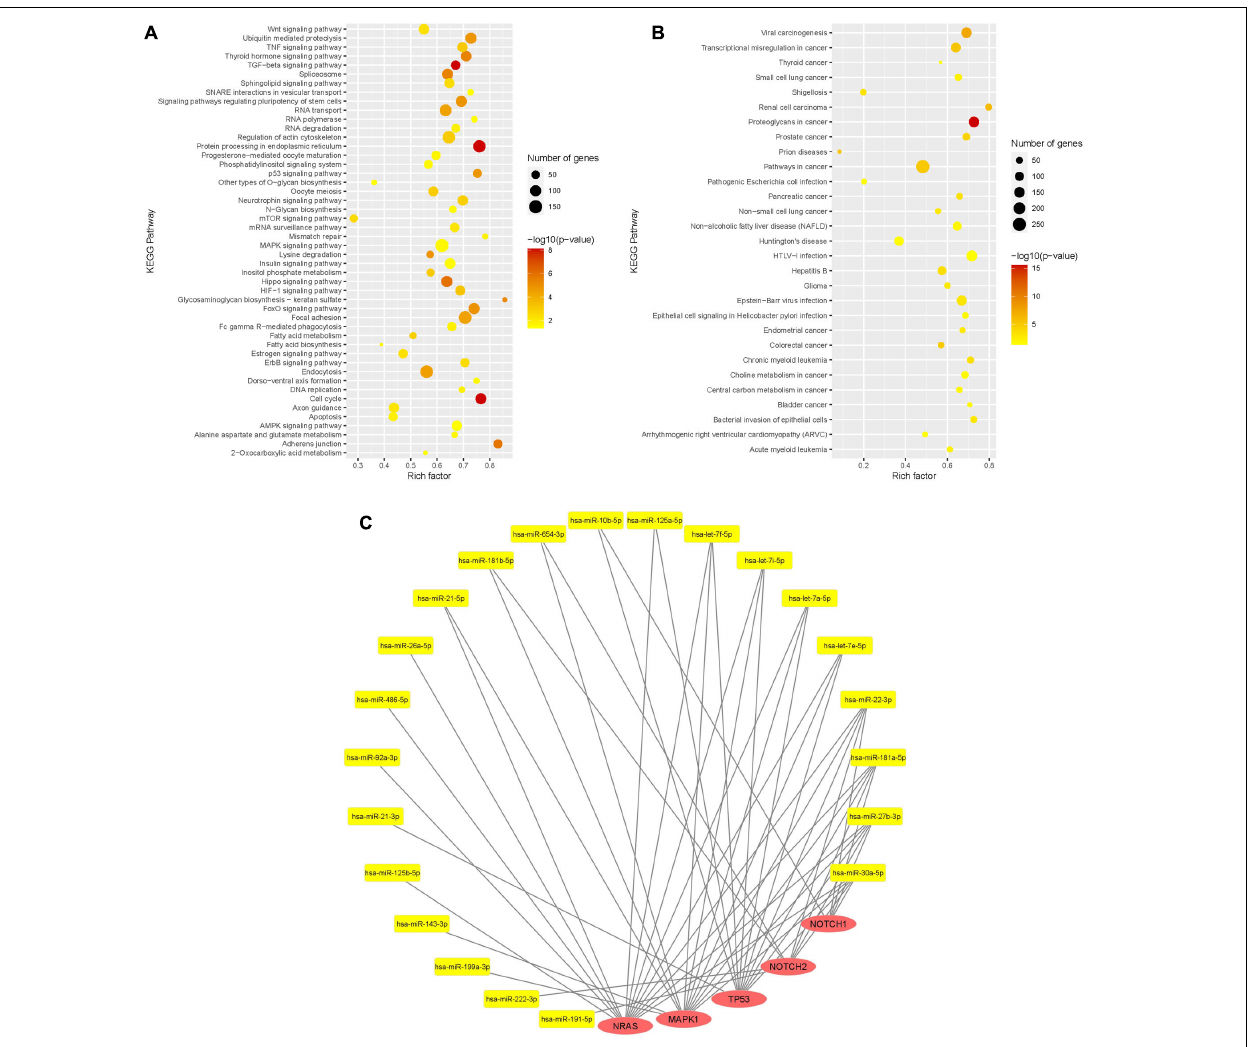
FIGURE 5 | Functional analysis of WJ-MSC-derived sEV miR. (A,B) Scatter plot of the Kyoto Encyclopedia of Genes and Genomes (KEGG) pathway enrichment analysis of sEV miR (mean normalized counts > 10,000) subdivided into general pathways (A) and disease-related pathways (B) . (C) miR-mRNA interaction network of sEV miRs (yellow) and their target genes (red) being relevant in oligodendrocyte